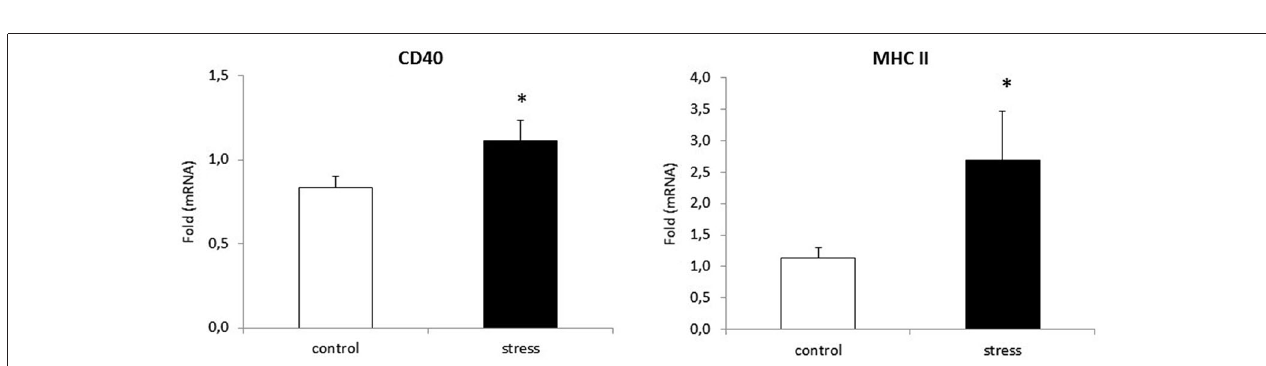
FIGURE 4 | Prenatal stress enhances the expression of: CD40 and MHC II markers in microglial cell cultures . The expression of mRNA is presented as average fold ± SD from 3 independent experiments ( n = 6 in each group), * p < 0.05; one-way ANOVA.